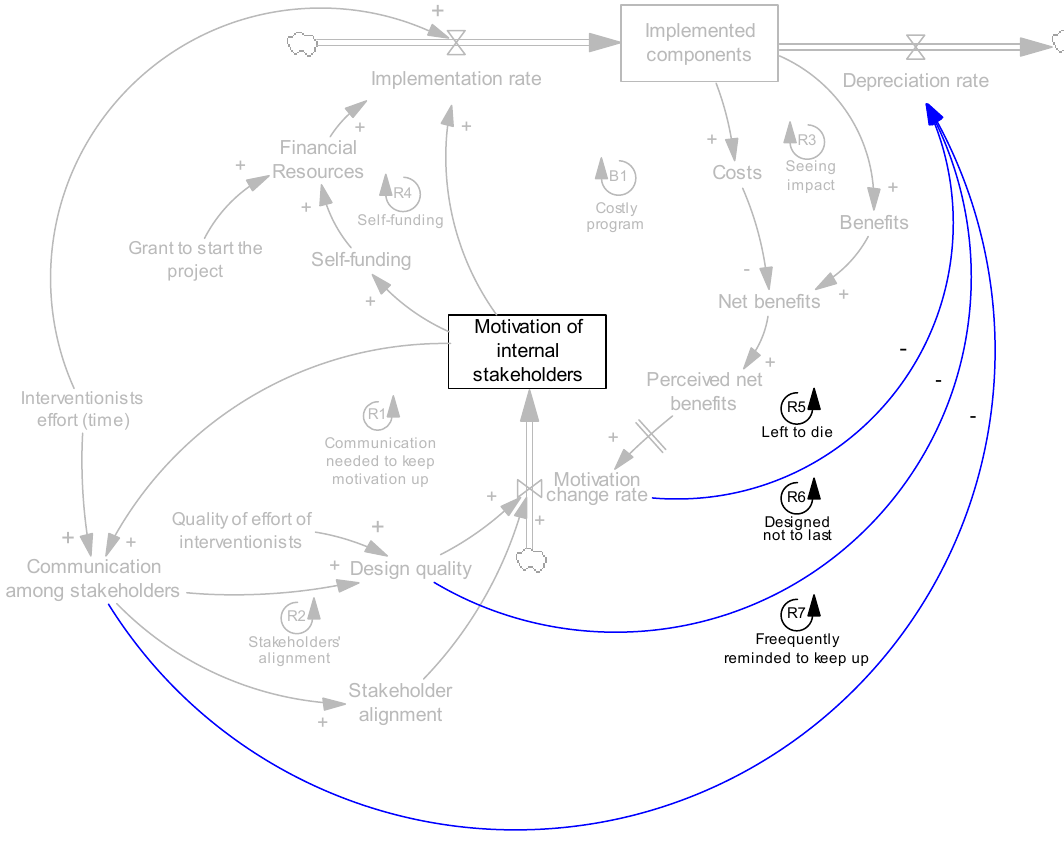
Figure 8. Effects of motivation, communication, and design quality on maintenance of intervention.